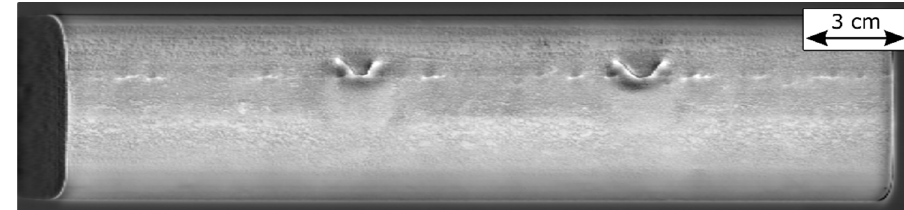
Figure 13. Resulting phase image of a measurement with a scanning speed of 200